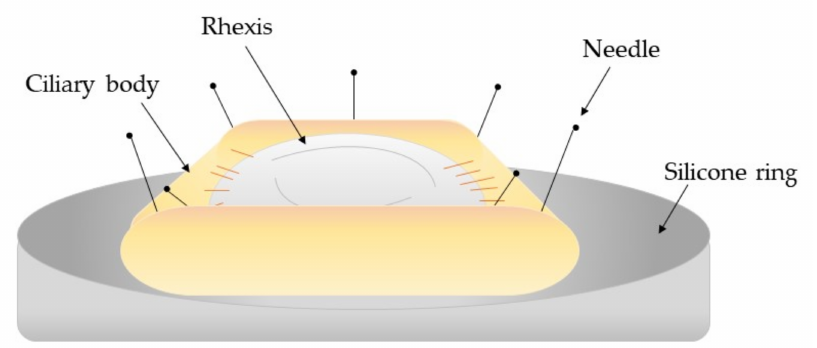
Figure 4. Schematic diagram of the capsule-ciliary body complex attached to a silicone ring mount